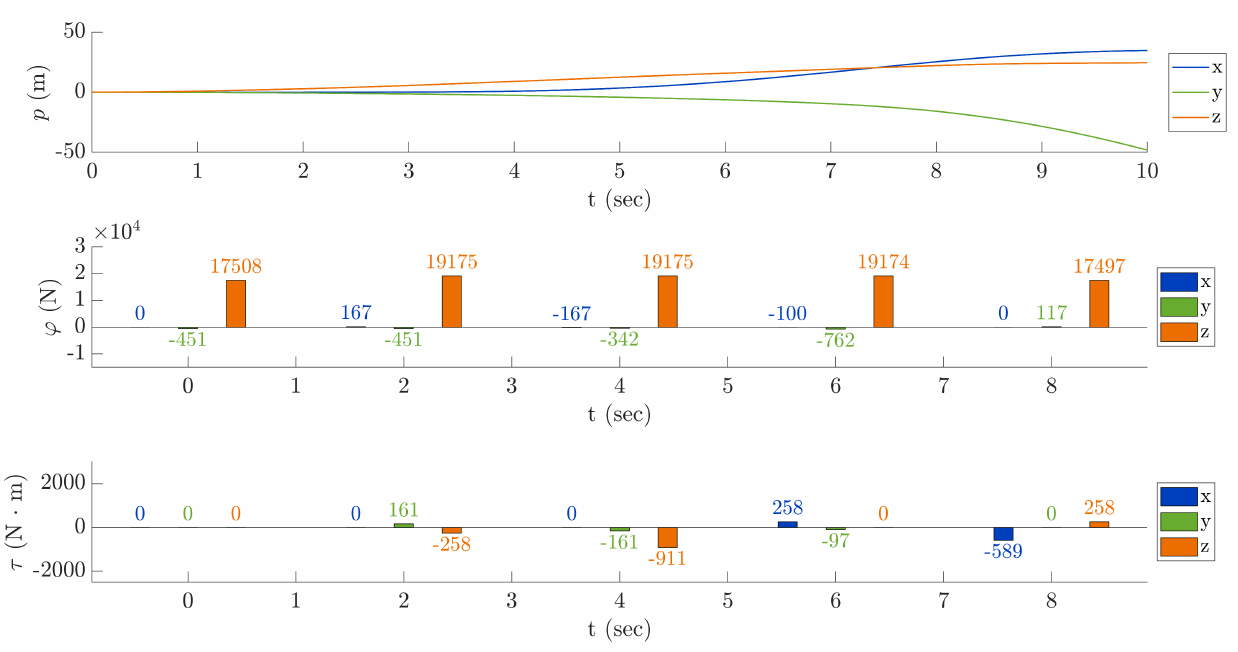
Figure 18. Eighth test—free flight.